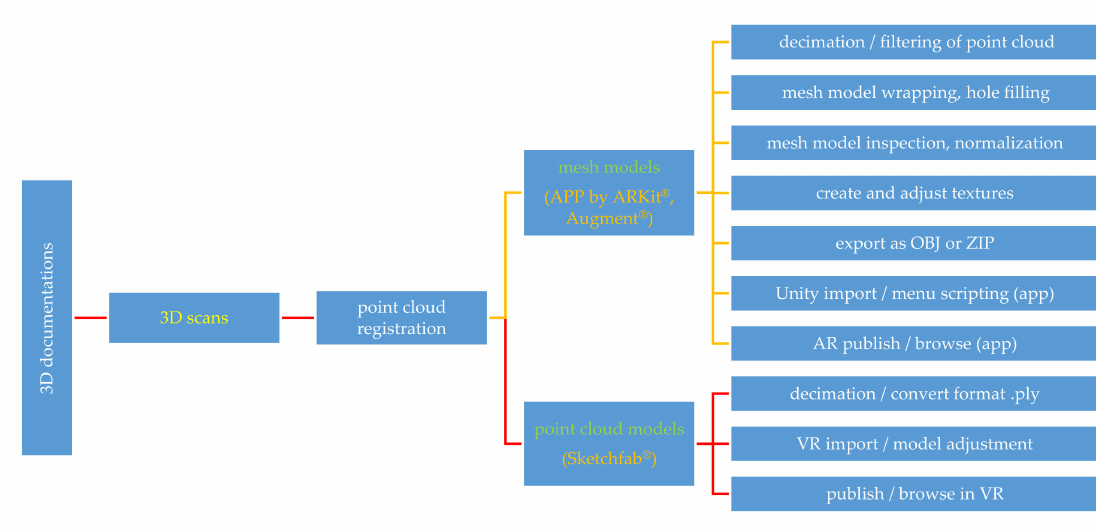
Figure 2. The data